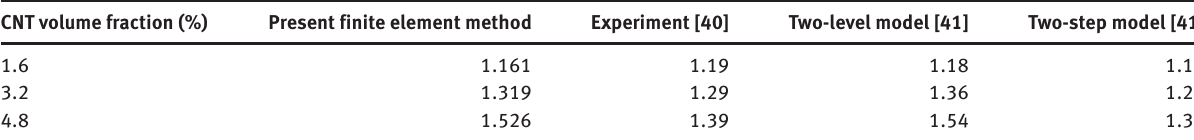
Table 2: Normalized elastic modulus of CNT-reinforced polypropylene with randomly oriented reinforcements (aspect ratio = 100). CNT volume fraction (%)